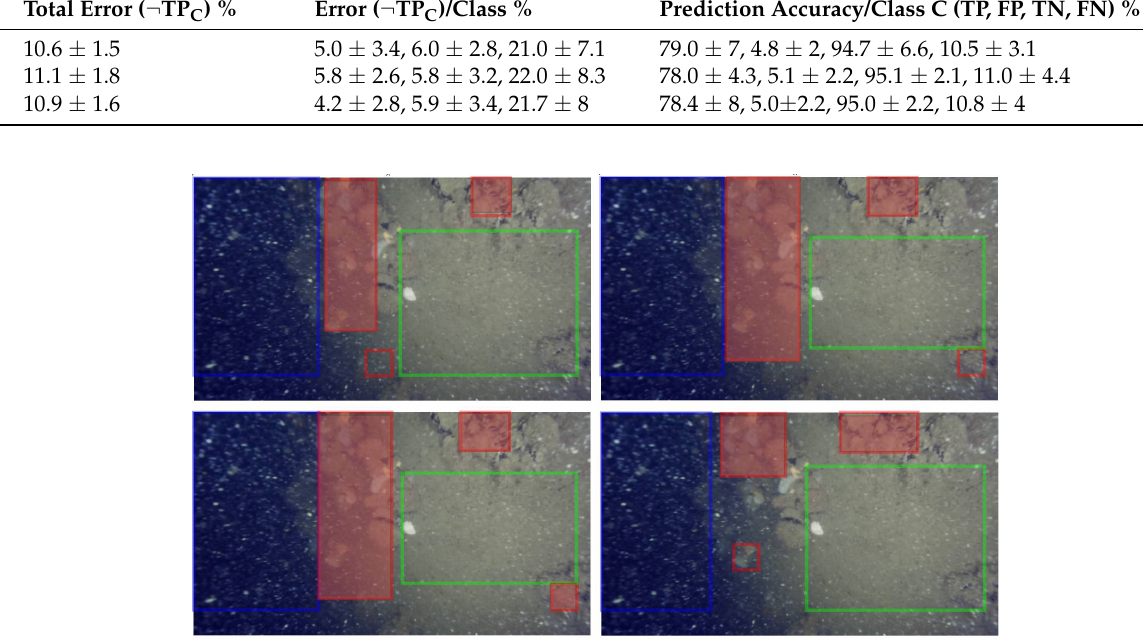
Figure 5. Classified bounding boxes for one image using four models trained in parallel (same pa- rameters) but with different random initialisation and training data sub-sets (Blue: class background, red: class coverage, green: class-free construction surface). Table 1. Accumulated prediction results for the training and test data and the entire dataset com- bined, with statistical features of the model ensemble trained in parallel (using different data sub- sets and random initialisation). All errors have a 2σ standard deviation interval, and N = 9000 sam- ples, n = 3000 for each class, using CNN architecture A.